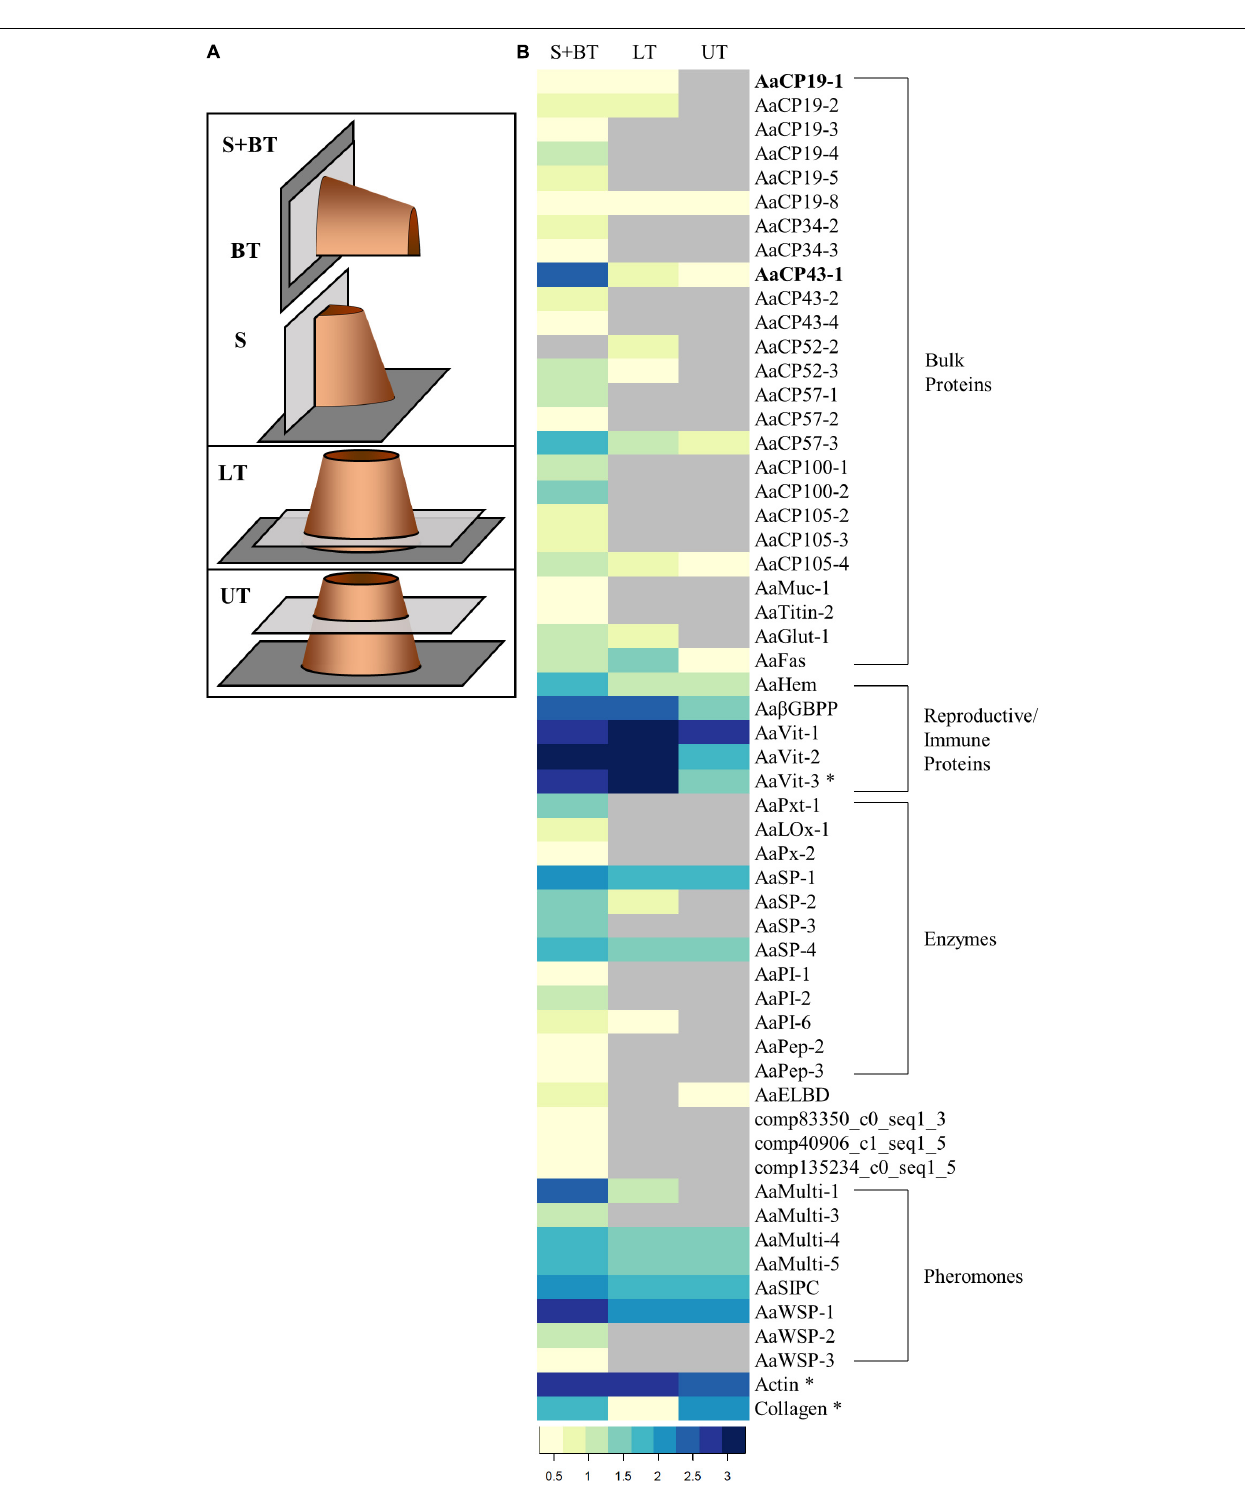
Frontiers in Marine Science |